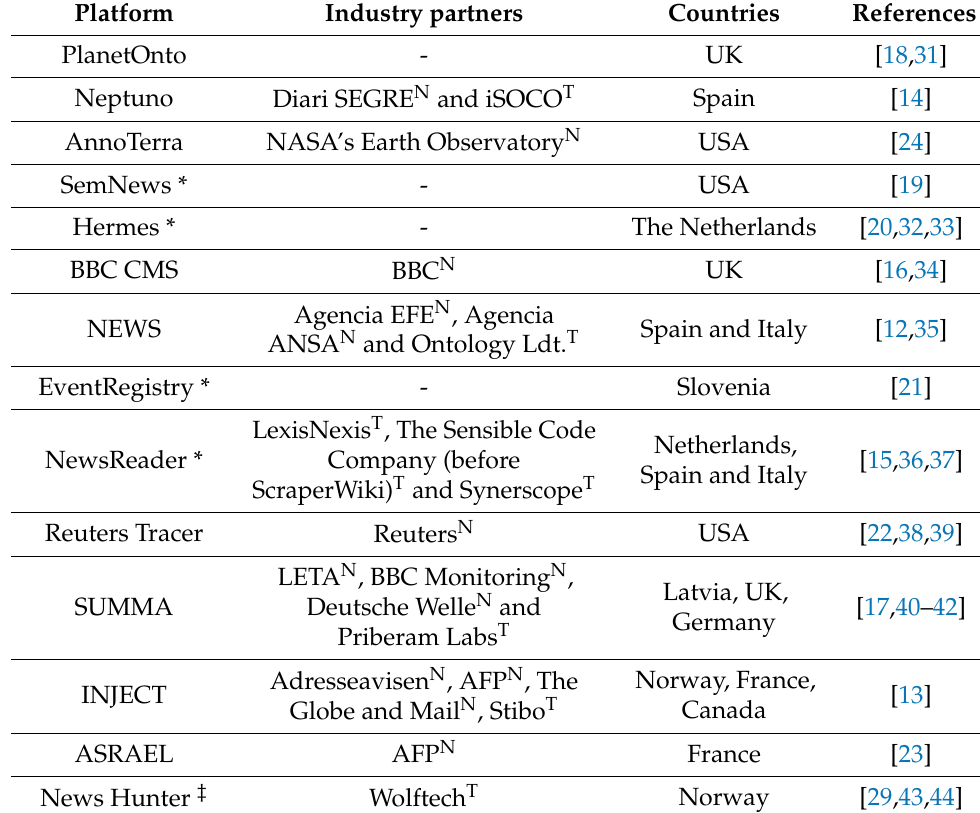
Table 1. Selected platforms. N: news media partner and T: technology partner. The identified countries represent the news media partners’